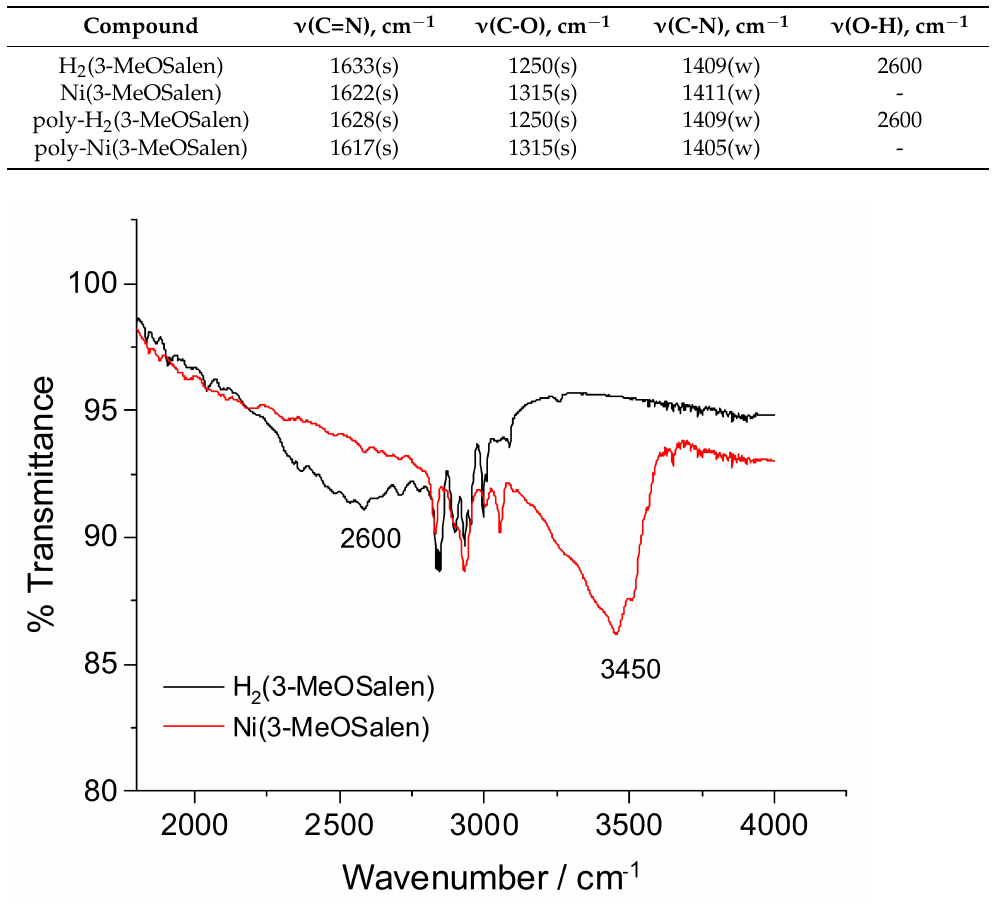
Figure 2. IR-spectra of the monomeric nickel complex Ni(3-MeOSalen) and the monomeric ligand H 2 (3-MeOSalen) in the frequency range of O-H